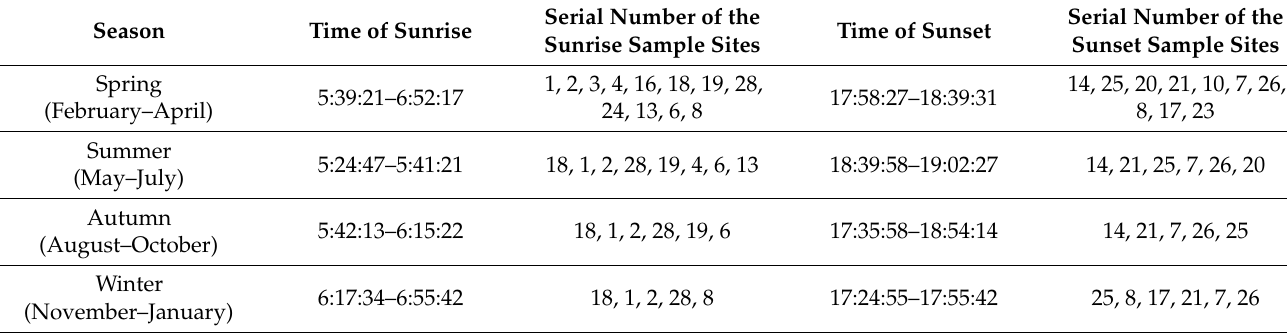
Table 6. Timetable of sunrise and sunset positions in different seasons.